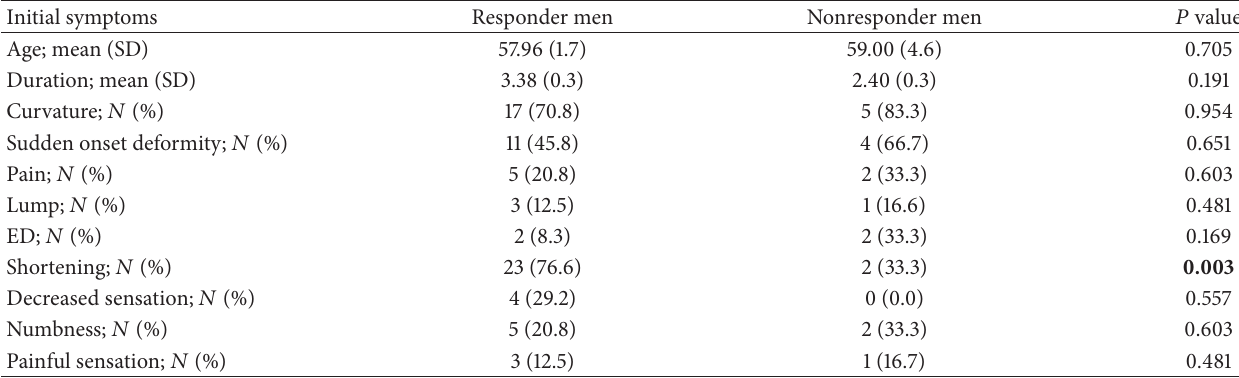
Table 1: Age at initial presentation, duration of symptoms, and clinical manifestations among responder and nonresponder men, expressed as mean (SD) for year and numbers (percent) for clinical manifestations.